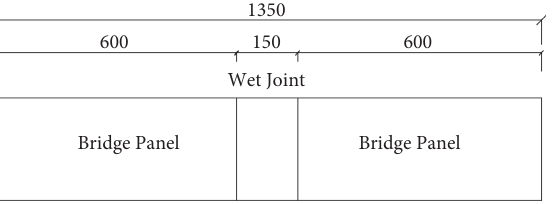
Figure 6: Dimension of the experiment